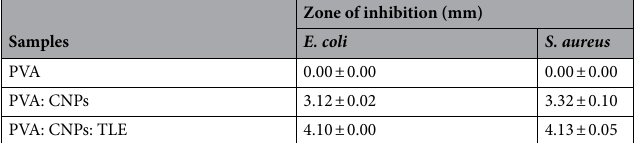
Samples PVA 0.00 ± 0.00 0.00 ±